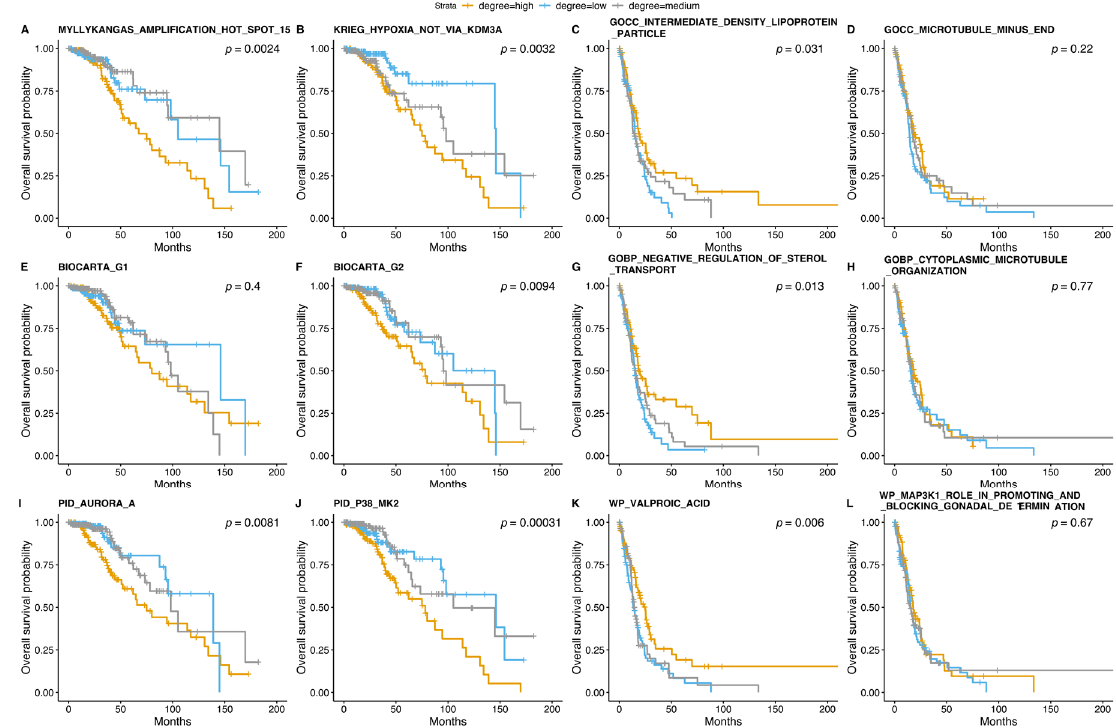
Figure 5. Survival curves of several NOIs characterized based on rule networks. We investigated NOIs for the topmost predictive three MSigDB collections discerning glioma grades: ( A – D ) CGP and GOCC, ( E – H ) BioCarta and GOBP, and ( I – L ) PID and WP. Each plot displays a p -value that was estimated with the default set of parameters while constructing the curves (Table S1).